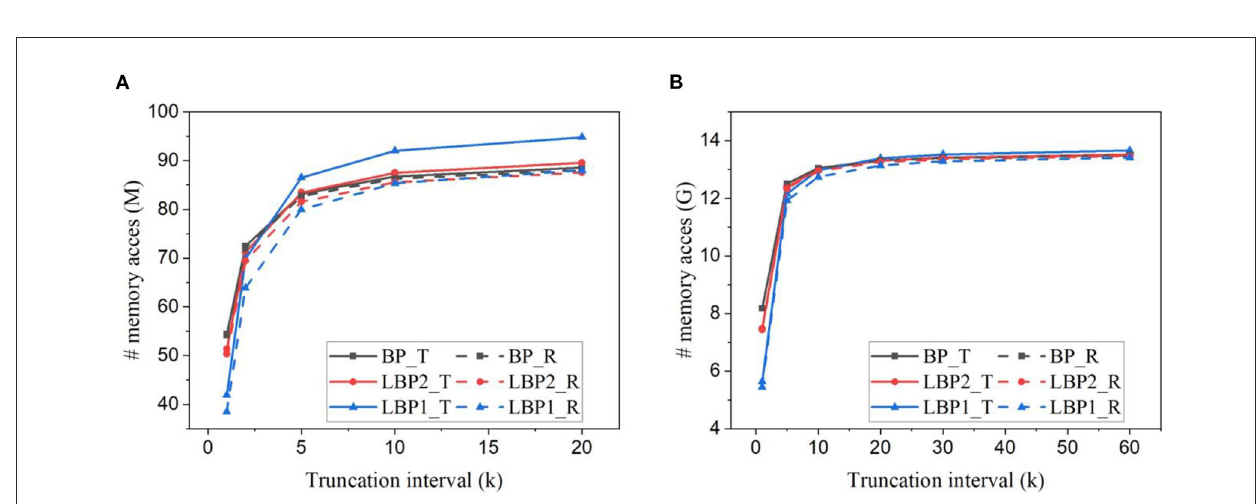
FIGURE9 Number of memory access estimated for training (A) LeNet-1 on EMNIST dataset and (B) LeNet-2 on DvsGesture dataset for one batch iteration. Solid lines and dashed lines represent the results obtained with trainable (T) classifiers and random (R) classifiers, respectively. The batch size is 128.